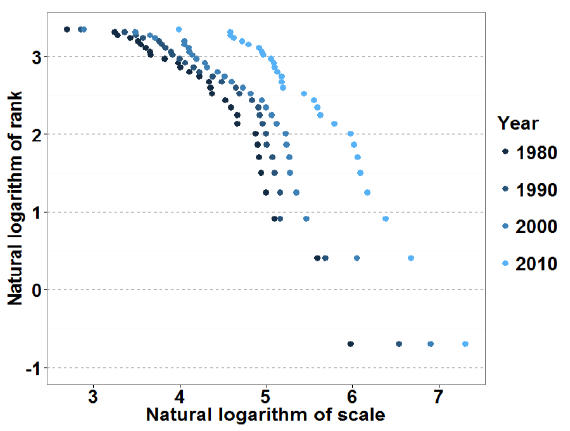
Figure 8. Rank-size distributions of cities in YRD